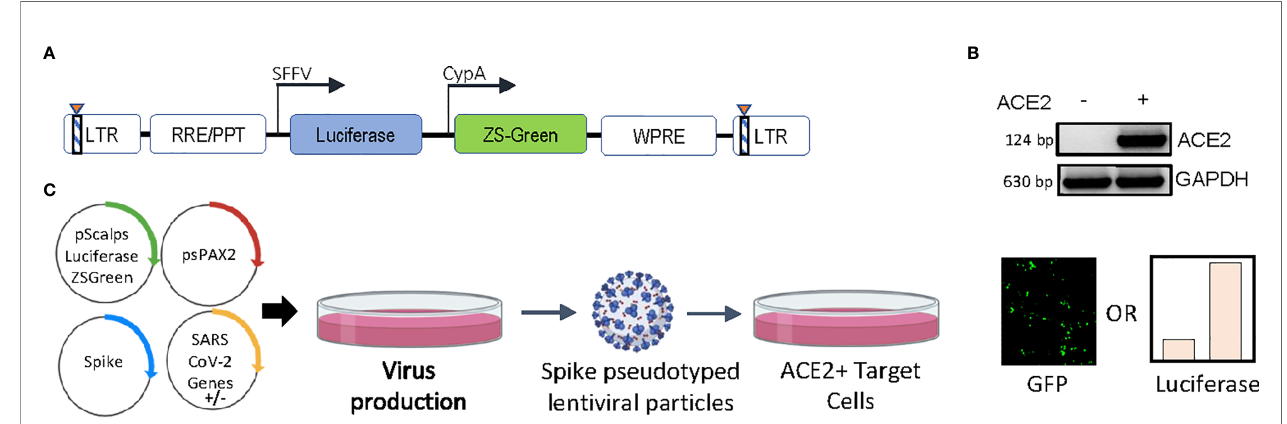
FIGURE 1 | Experimental setup and constructs. (A) Schematic representation of the pScalps Luciferase Zsgreen lentiviral reporter construct. (B) ACE2 expression from the hygromycin selected HEK293T cell line transduced with a ACE2 gene carrying lentiviral vector. (C) Schematic depiction of the SARS CoV-2 genes ’ screen. Transfection with an empty vector served as control. Readout from the screen was obtained in the form of fi re fl y luciferase activity or GFP-positive